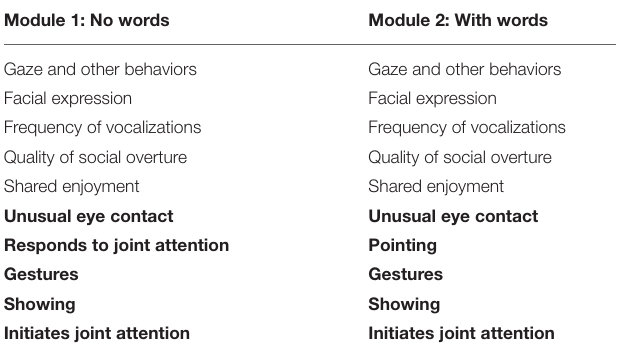
TABLE 1 | ADOS social affect scale items with joint attention factor items in